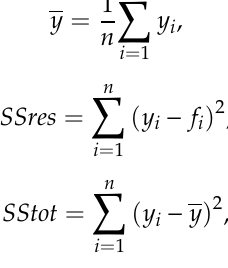
Figure 8 . Comparison of the measured path loss with the propagation models (sand). ( a ) wet sand; ( b ) dry sand.